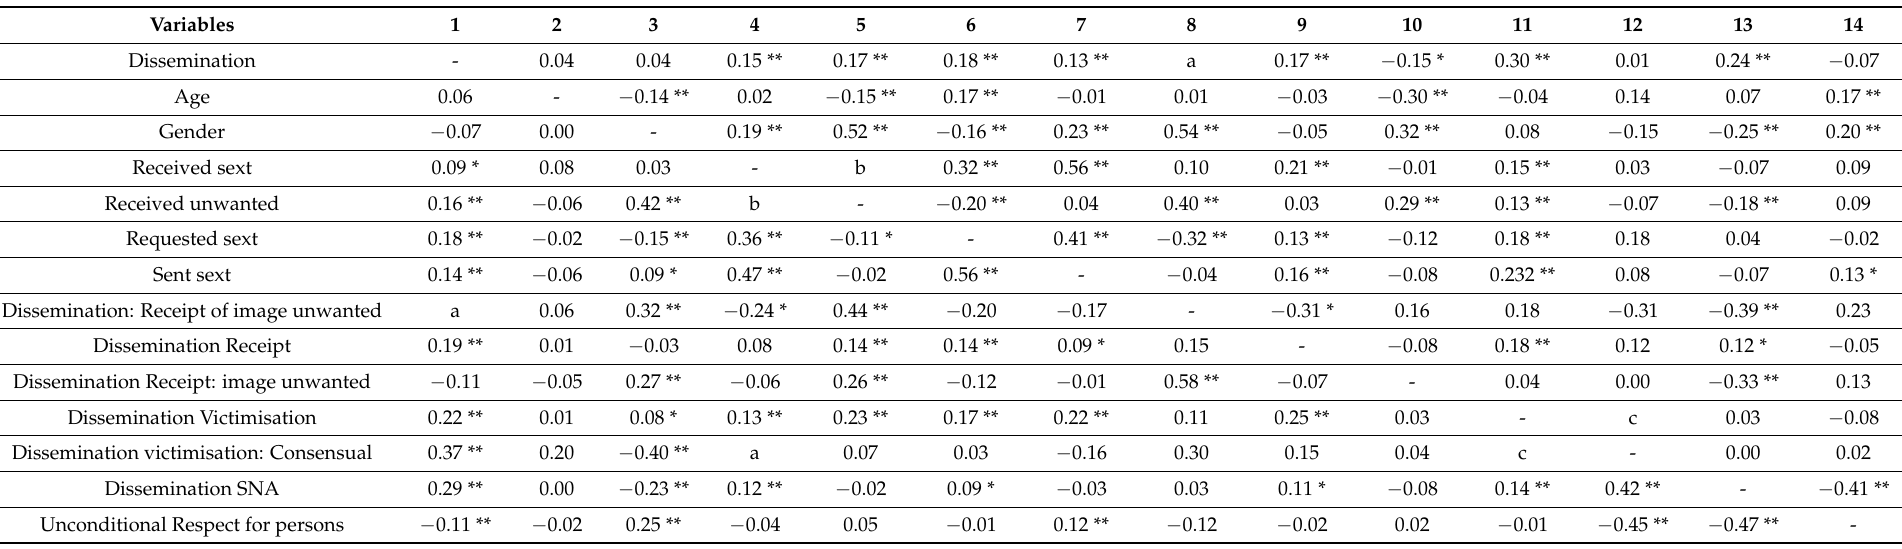
Table 3. Correlations for key variables: upper triangle represents Australian participants, lower triangle represents U.S.